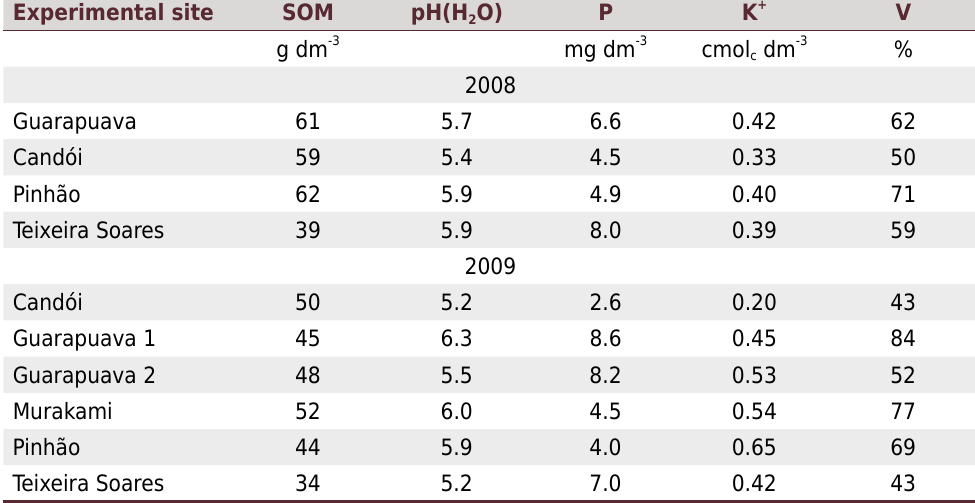
Table 3. Soil chemical properties in the South-Central region of Paraná where the experiments to determine the apparent N mineralization from soil organic matter were conducted Experimental site SOM pH(H 2 O) P K + V g dm -3 mg dm -3 cmol c dm -3 % 2008 Guarapuava Candói 59 50 Pinhão 62 0.40 71 Teixeira Soares 39 5.9 8.0 0.39 2009 Candói 50 Guarapuava 1 Guarapuava 2 Murakami Pinhão 44 5.9 69 Teixeira Soares OM: soil organic matter (Walkley-Black); P: available phosphorus (Mehlich-1); K + : exchangeable potassium (Mehlich-1); and V: base